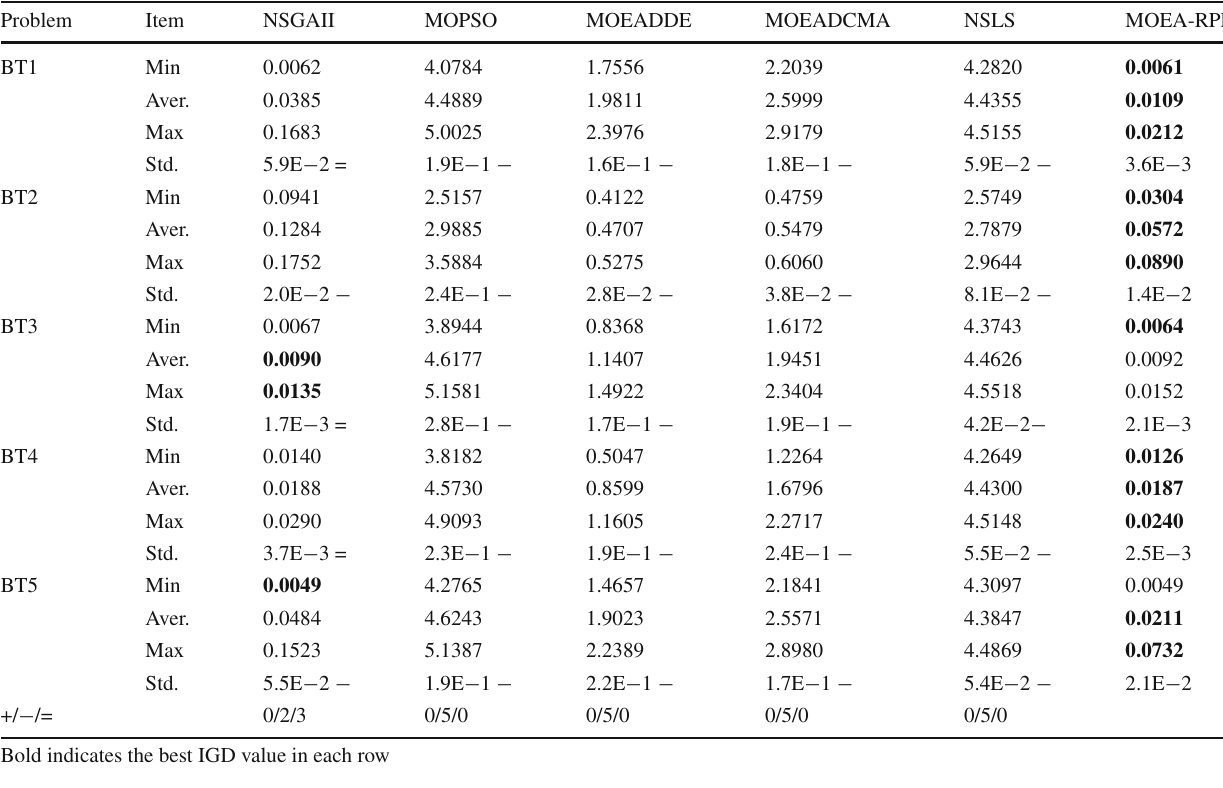
Table 1 The IGD values (best, medium, and worst) on BTs Problem